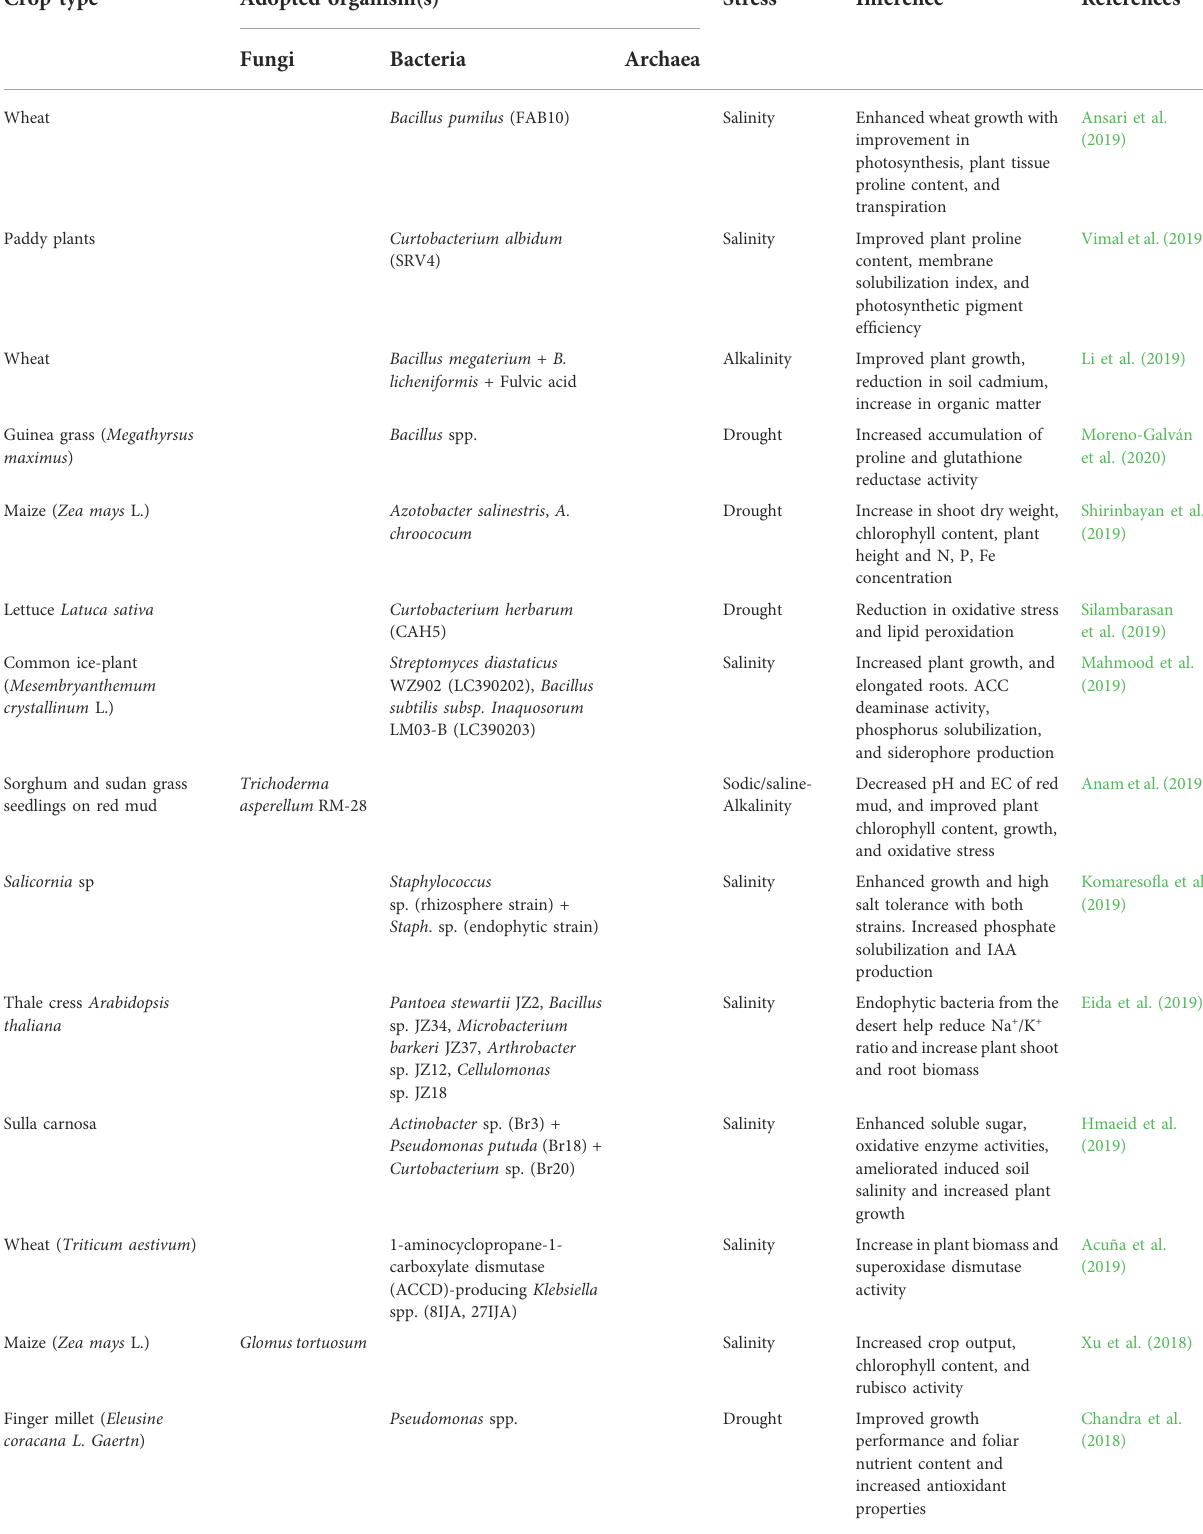
TABLE 1 Examples from the recent literature of the effect of plant growth-promoting microbes in the relief of plant